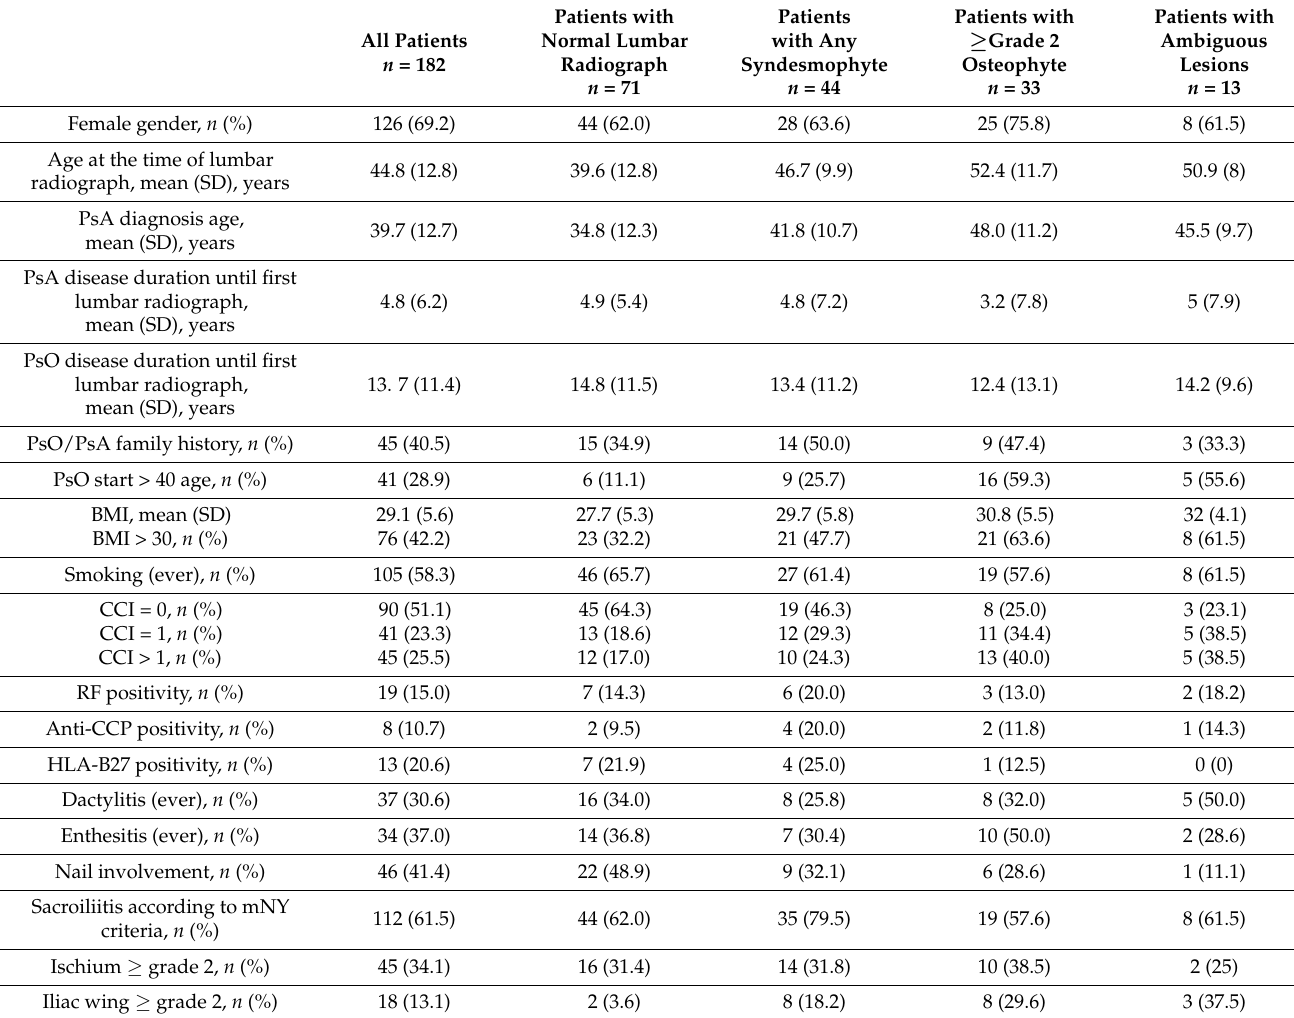
Table 1. Demographic and clinical characteristic of patients according to lateral lumbar radiography findings.